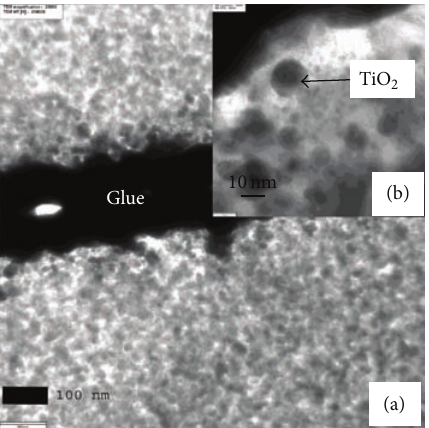
Figure 6: A cross-sectional TEM micrograph of the TiO 2 /MgO (0.10nm) composite films prepared from 1 × 10 −3 M of magnesium acetate solution (a) × 20,000, (b) × 200,000.